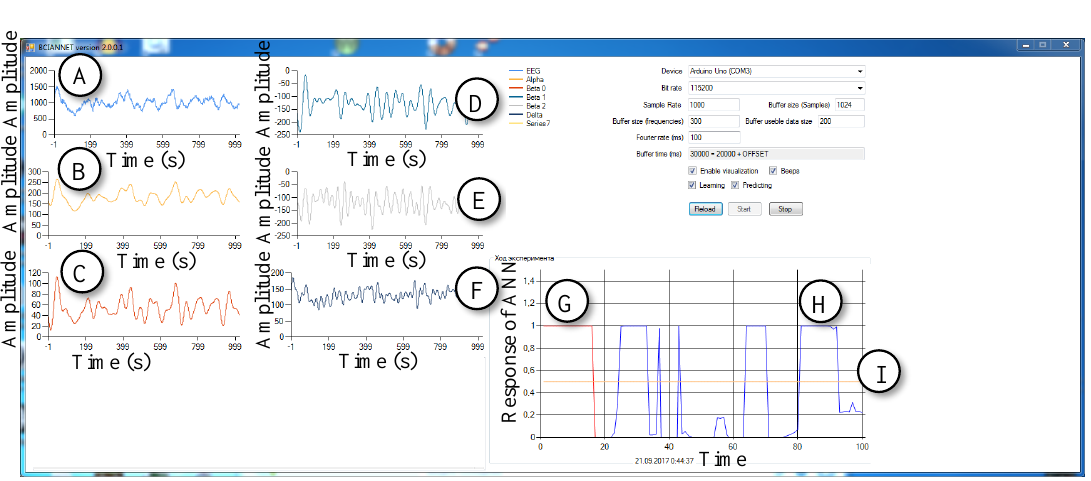
Figure 10. The final version of the software BCIANNET v 2.0.0.1. It assesses the state of a person using the artificial neural network (ANN). Light blue ( A ) — raw EGG. Yellow ( B ) — alpha waves. Red( C ) — beta 0 waves. Cyan ( D ) are beta 1 waves. Grey ( E ) — beta 2 waves. Dark blue ( F ) — delta waves. Red ( G ) — graph displaying the status of the experiment (1 or 0). Blue ( H ) — graph indicating neural network predictions. Yellow ( I ) — mean value from experiment states from array of data, which is used as an output dataset for neural network learning (0.5 value means that everything is normal).